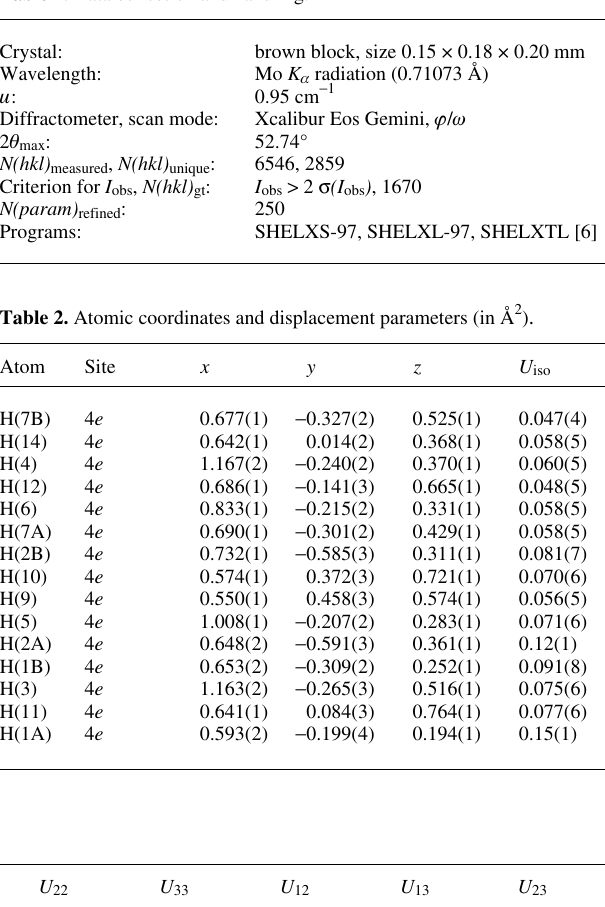
Table 1. Data collection and handling.